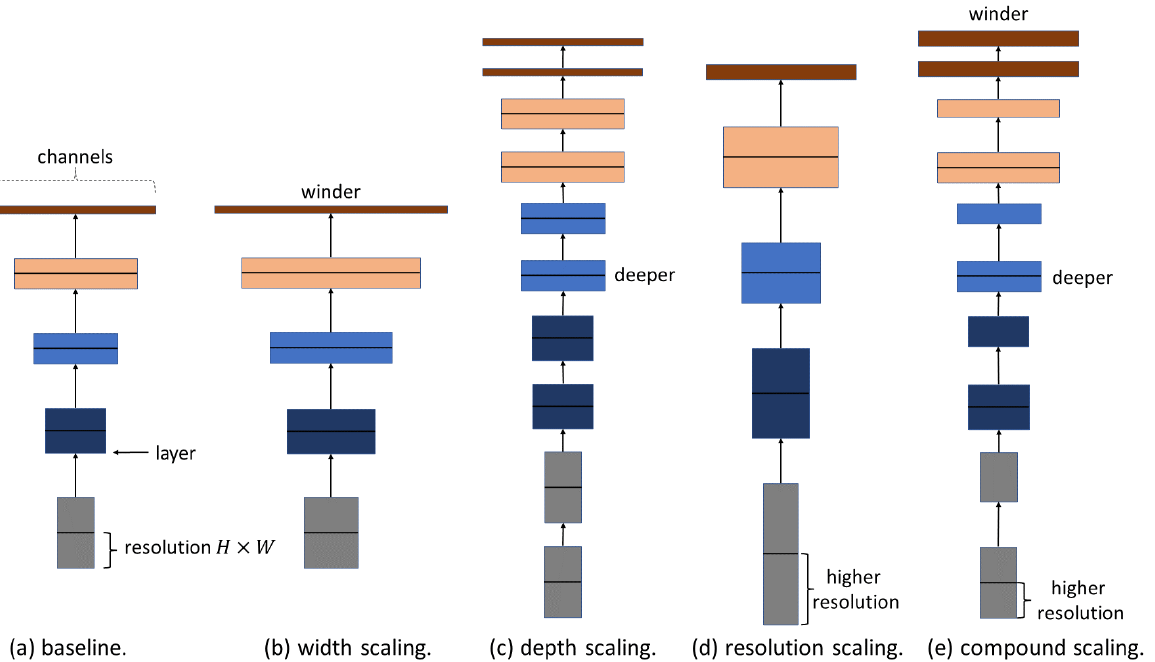
Figure 2. Architectural representation of standard and composite scaling methods. ( a ) ConvNet generic, ( b ) ConvNet with width scaling, ( c ) ConvNet with Depth scaling, ( d ) ConvNet with resolution scaling, and ( e ) ConvNet with compound